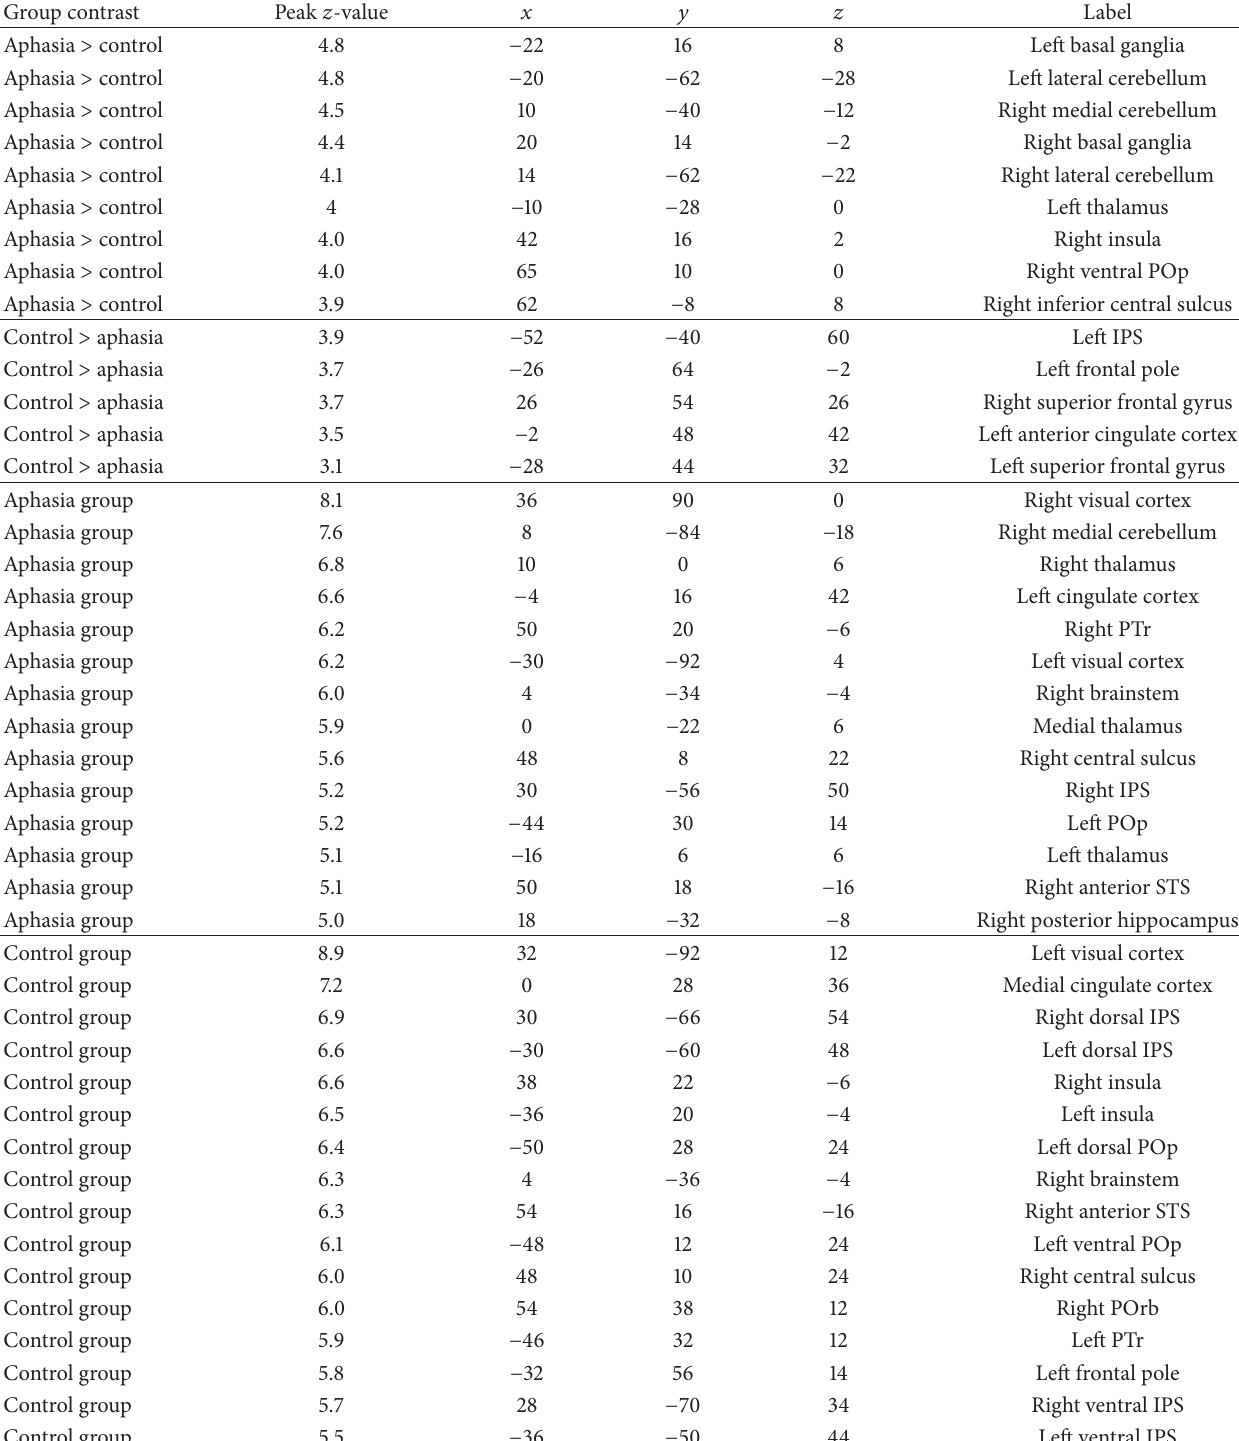
Table 2: MNI coordinates of activity in the covert naming > fixation